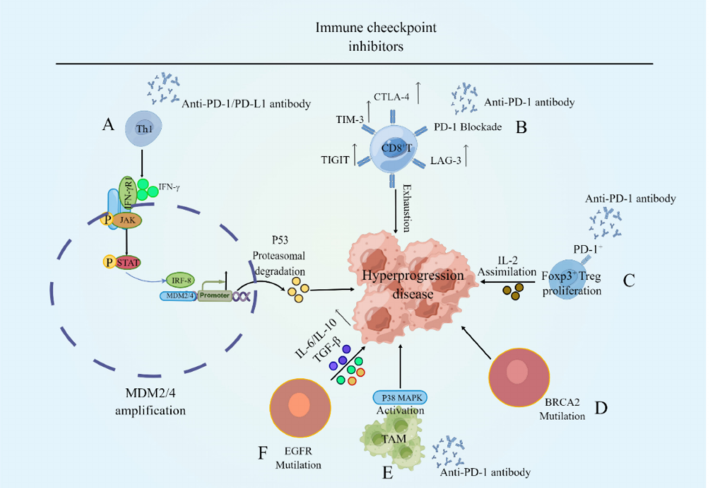
Figure 2. The mechanisms of HPD. ( A ) ICIs treatment causes Th cells to oversecrete IFN- γ , causing IRF-8 expression in the JAK-STAT pathway to be activated. IRF-8 binds to the MDM2/4 promoter, causing the MDM2/4 gene to be amplified, resulting in the loss of p53 activity and the acceleration of tumor growth. ( B ) When PD-1 is blockaded, T cells in the tumor microenvironment upregulate the expression of other immunological checkpoints such as CTLA-4, LAG-3, and TIM-3, resulting in tumor development. ( C ) Immunosuppression of Foxp3+PD-1+ Treg cells is lifted following PD-1 blocking, allowing Treg cells to proliferate and take up IL-2 while inhibiting effector T cell anti-tumor actions. ( D ) ICIs treatment in breast cancer may result in BRCA2 oncogene mutations and the development of HPD. ( E ) ICIs produce weak anti-tumor responses, resulting in increased activation of the p38 signaling pathway and tumor growth stimulation. ( F ) Mutations in EGFR drive innate immune upregulation of T cell suppressor receptors PD-1/PD-L1 and CTLA-4 expression, causing T cells to secrete pro-inflammatory cytokines such as IL-6, IL-10, and TGF- β and immune escape to